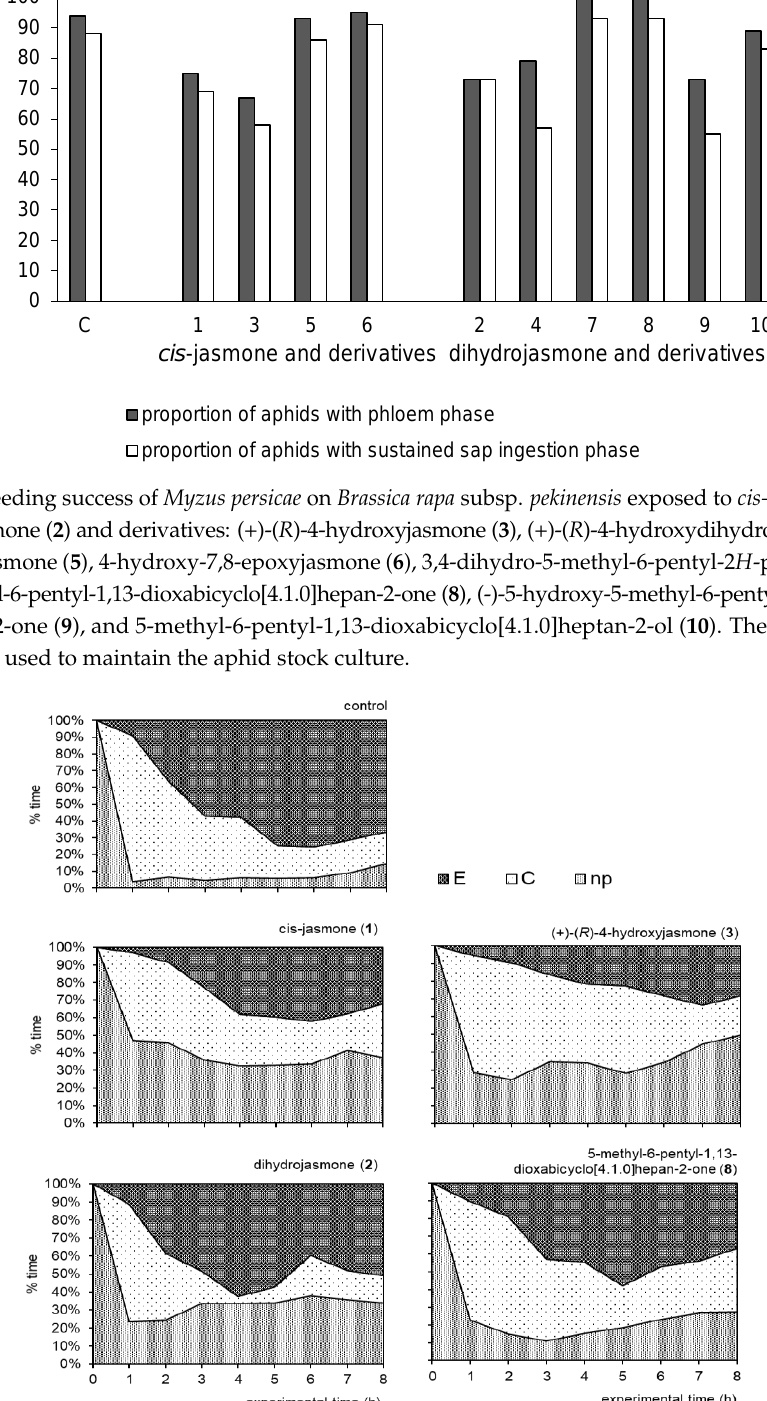
Figure 3. Sequential changes in Myzus persicae probing activity on Brassica rapa subsp. pekinensis exposed to cis- jasmone ( 1 ), dihydrojasmone ( 2 ), and the most active derivatives: (+)-( R )-4-hydroxyjasmone ( 3 ) (active deterrent as found in aphid settling assay by Gliszczy´nska et al. [31]) and 5-methyl-6-pentyl-1,13-dioxabicyclo[4.1.0]hepan-2-one ( 8 ) (active attractant as found in aphid settling assay by Gliszczy´nska et al. [32]). E: phloem phase (E1+E2), C: pathway phase (C+F+G), np: non-probing. The same plant species was used to maintain the aphid stock